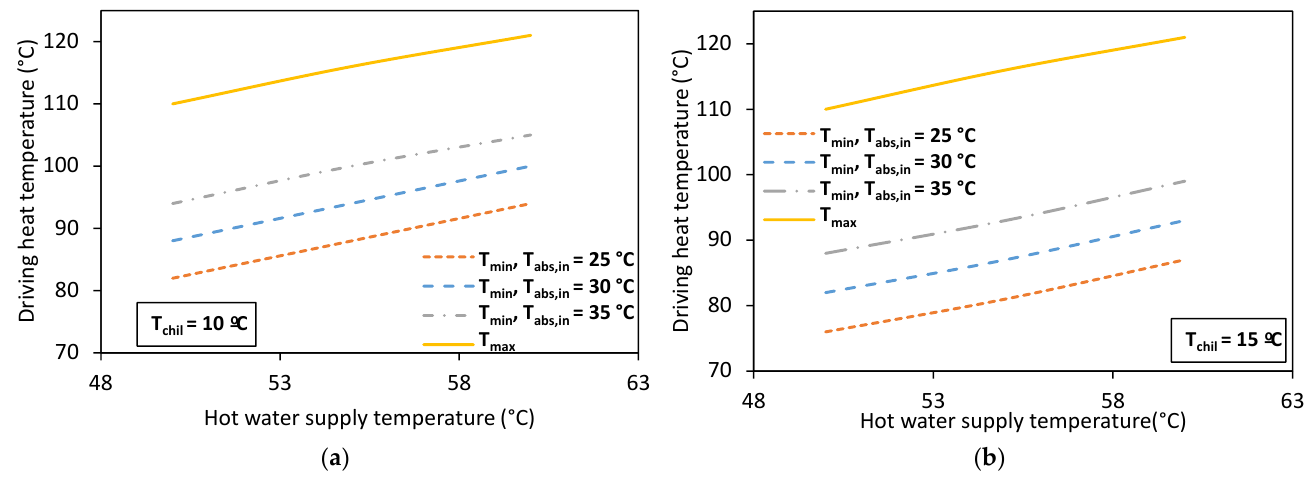
Figure 5. Minimum and maximum driving heat temperatures as function of the hot water supply temperature and absorber cooling water inlet temperature for a chilled water supply temperature of 10 °C ( a ) and 15 °C ( b ).